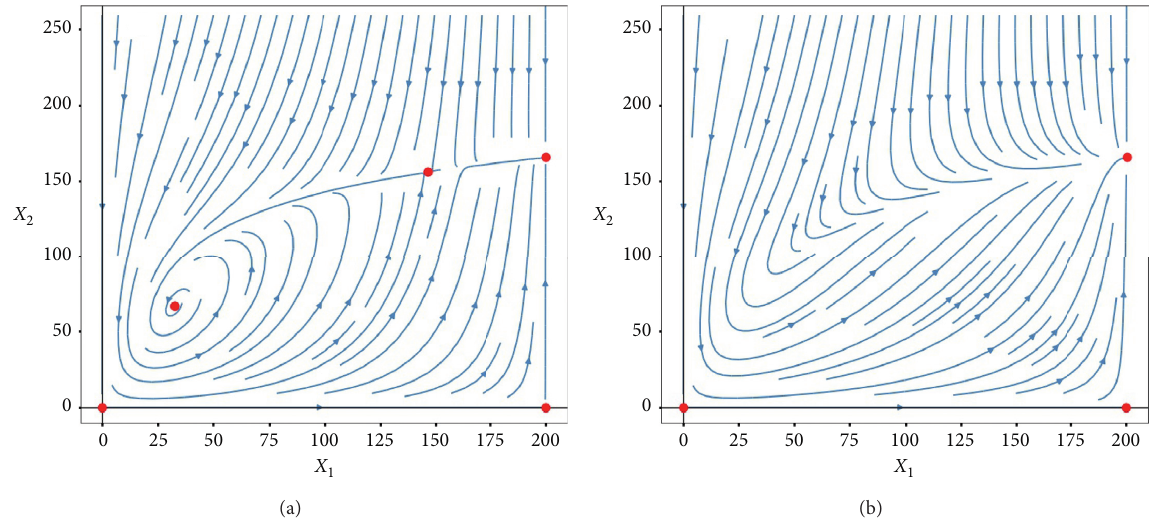
Figure 3: Population evolution in a predator-prey system with two preys: (a) prey-1 with cooperation b � − 0 . 15, b r 3 b